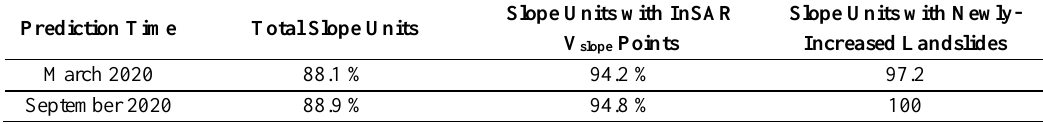
Table 2. The overall accuracy for landslide prediction